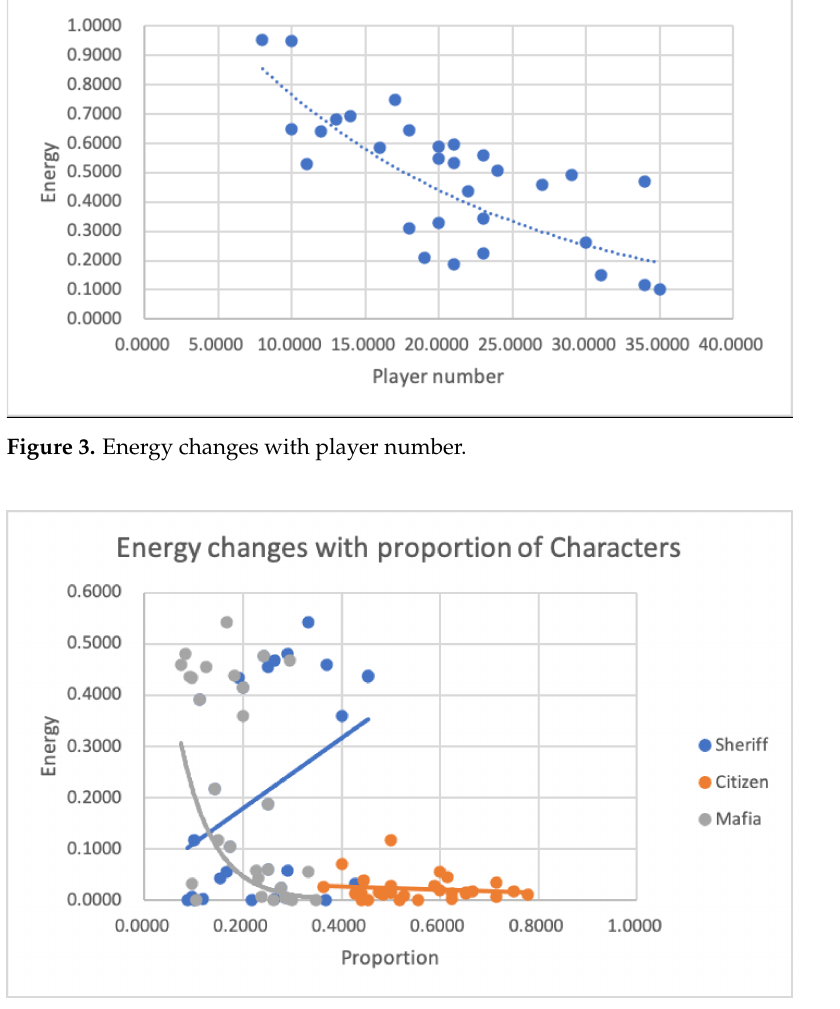
Figure 4. Energy changes with the proportion of